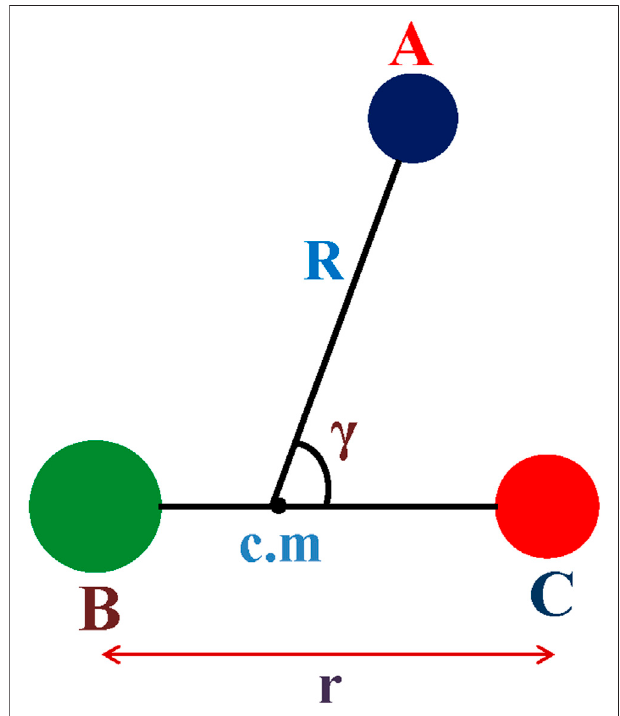
FIGURE 1 | Jacobi scattering